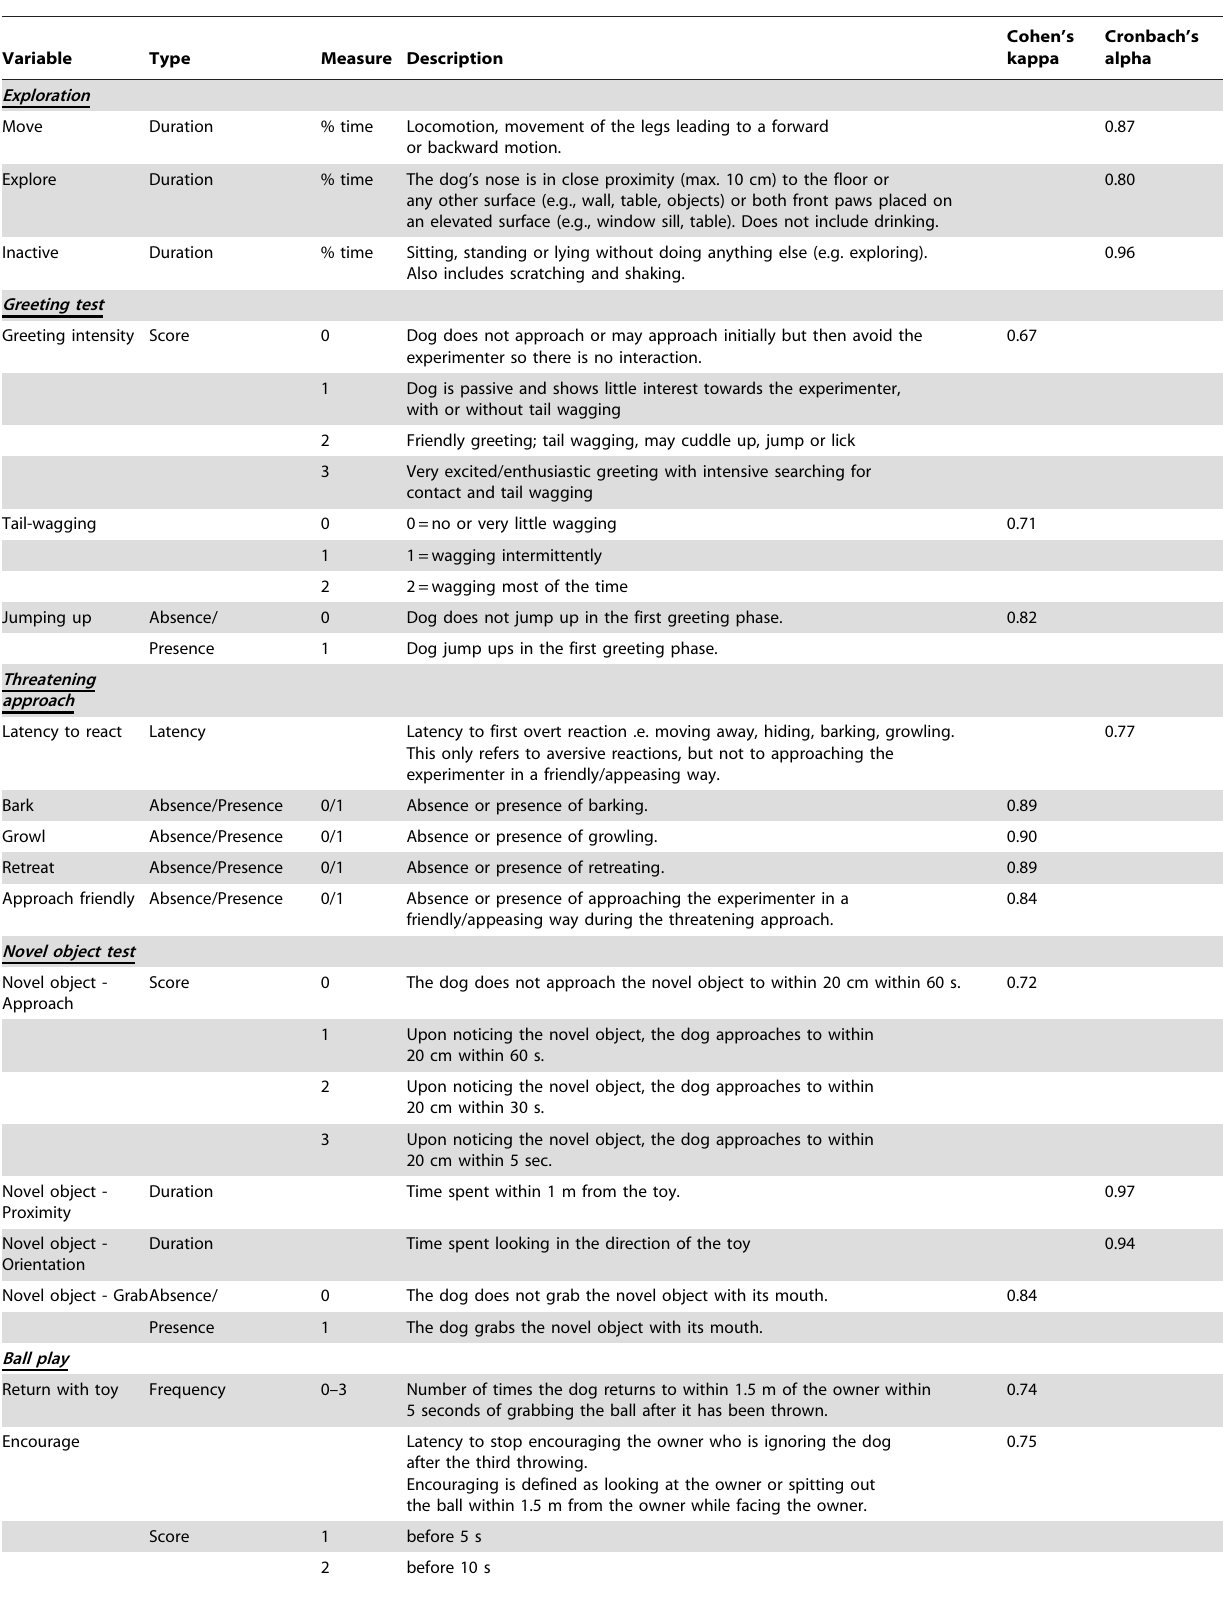
Table 6. Description of behavioural measurements used in the analysis of the adult test.